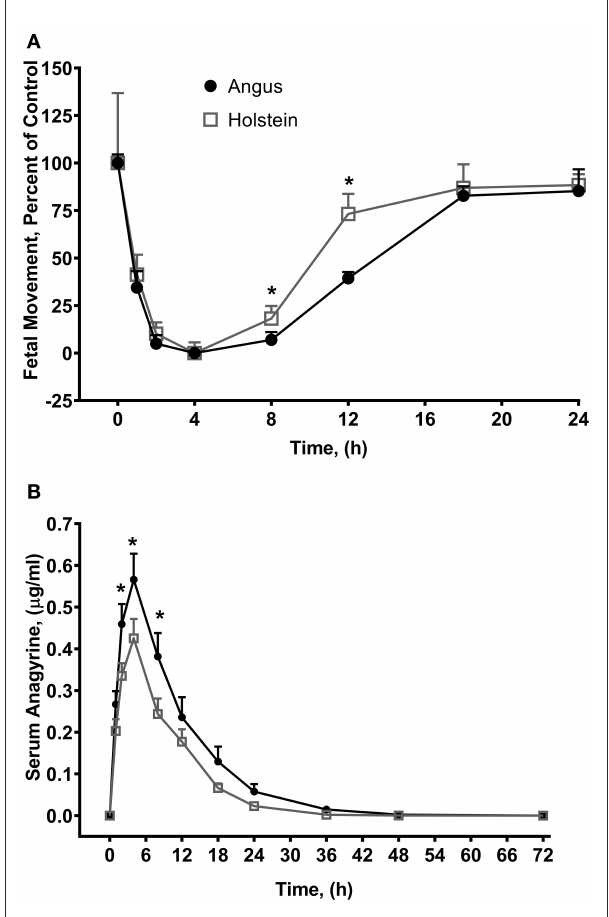
FIGURE5 Fetal movements (A) and serum anagyrine concentrations (B) in Angus and Holstein heifers orally dosed with 1.1 g/kg body weight dried ground L. leucophyllus (49). Fetal movements were counted by transrectal ultrasound for 5min and the number of fetal movements were normalized to time zero in the two breeds of cattle. Angus heifer fetuses averaged 42 ± 4 movements per five-minute sampling period and Holstein heifer fetuses averaged 31 ± 23 movements. Data represents the mean ± standard error. * P < 0.05 Angus ( n = 6) vs. Holstein ( n = 5) at each time point respectively ( t -test). Serum anagyrine concentrations and fetal movements are correlated (Holstein, P < 0.0001; Angus, P <